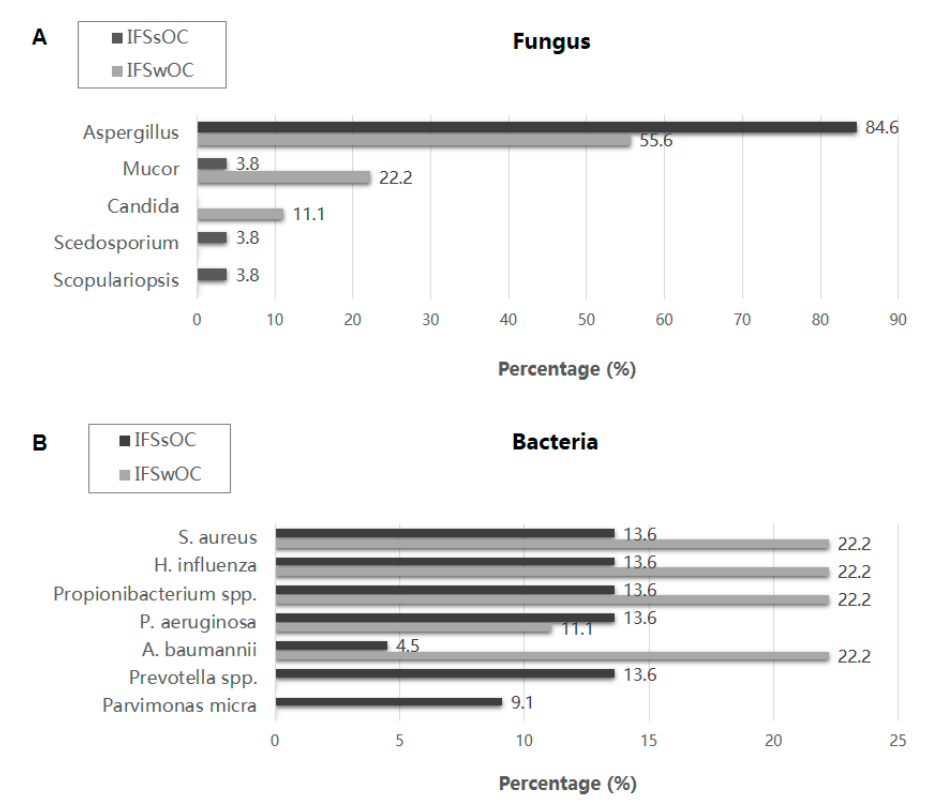
Figure 2. Microbiology in IFS ( A ) fungus and ( B ) bacteria.